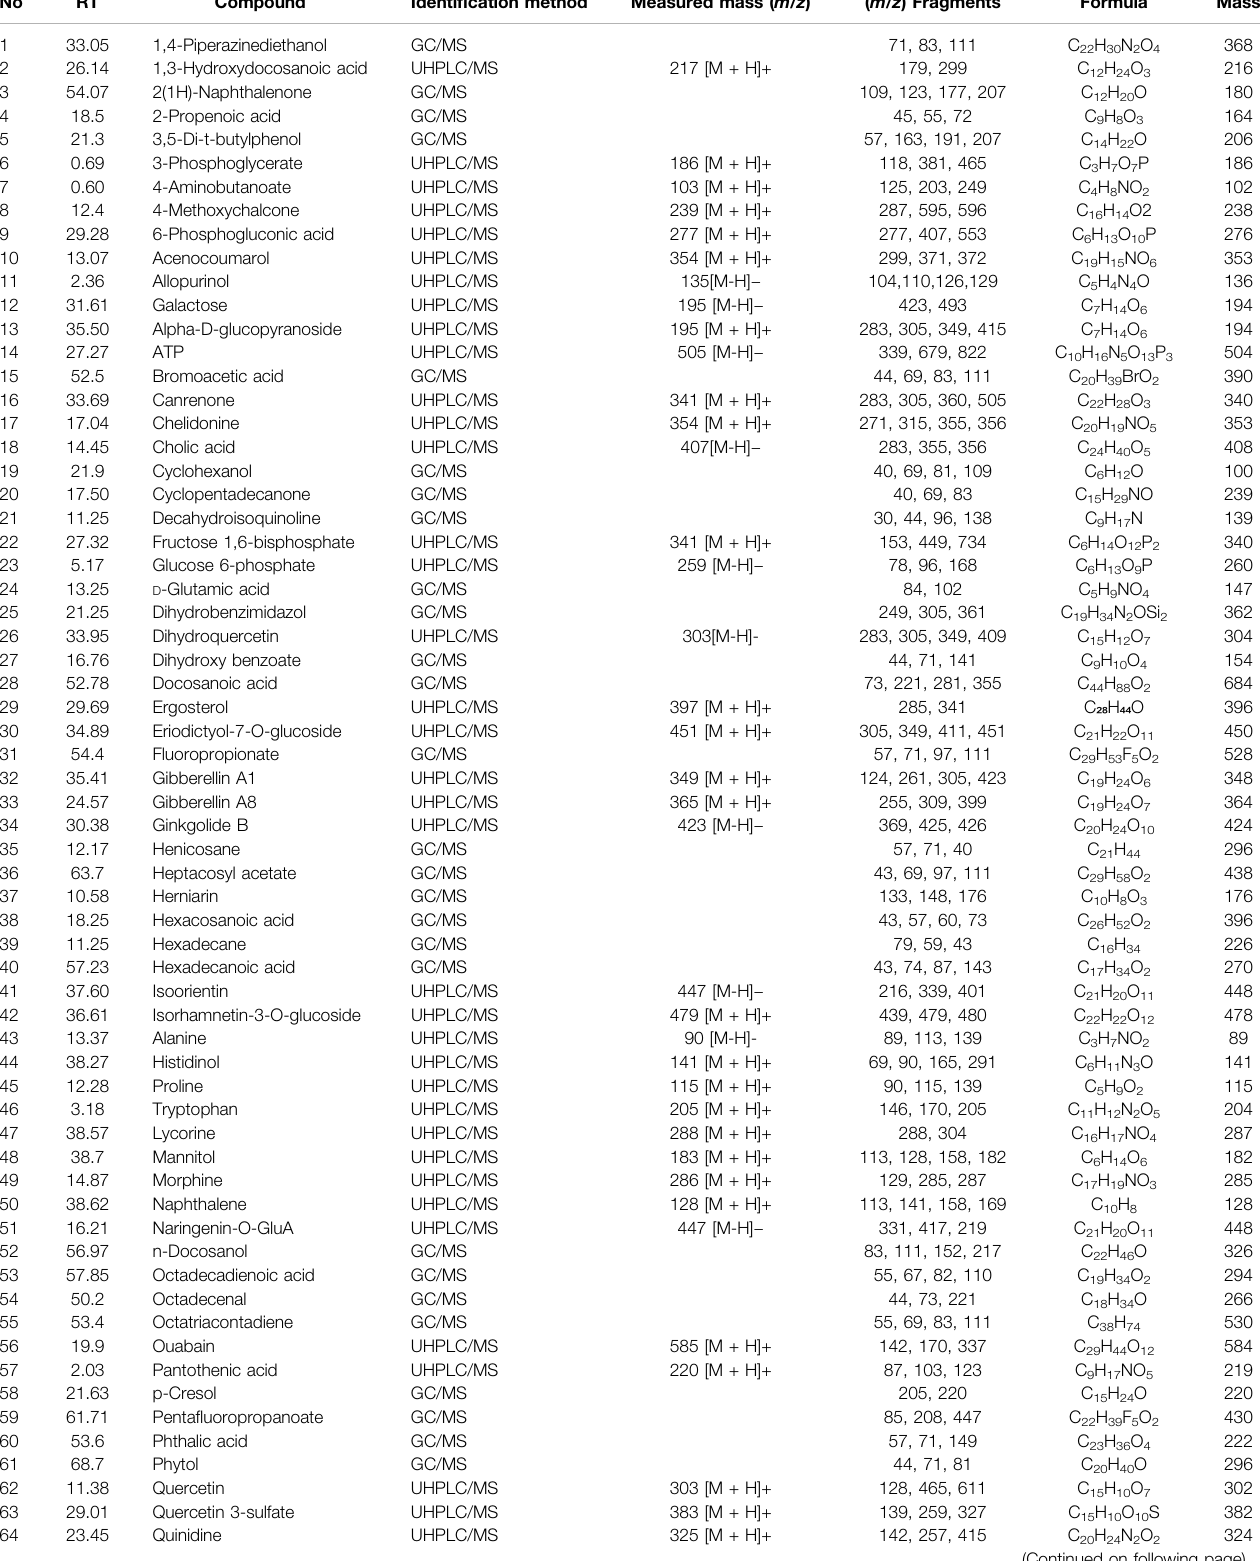
TABLE 1 | Details of different compounds detected in leaf material of G. uralensis by performing GC/MS and LC/MS